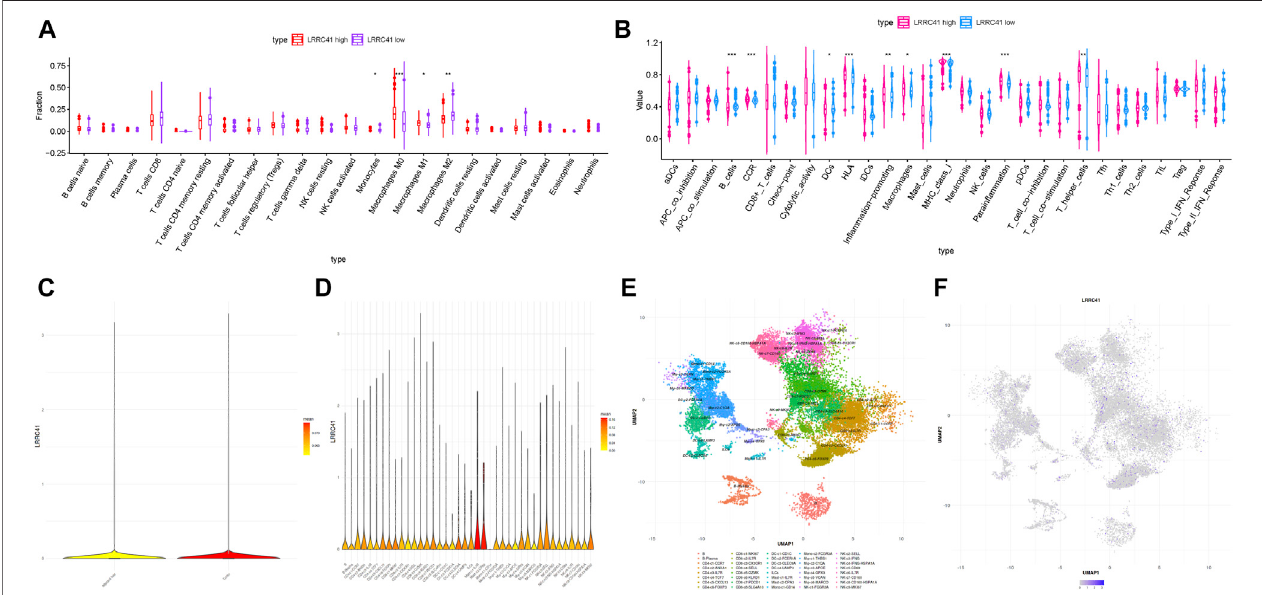
FIGURE9| DiscrepancyoflowandhighLRRC41expressionsubgroupsintermsofTIMEcharacterization. (A) ComparisonofCIBERSORTresultsintwoLRRC41 expression subgroups. (B) Difference of immune-related signatures between low- and high-LRRC41 subgroups. Single-cell RNA sequencing analysis of LRRC41 abundance in various tissues and immune cell subtypes of HCC patients. (C) Analysis of the enrichment of LRRC41 in tumor and adjacent liver. (D) Analysis of the enrichment of LRRC41 in immune cell subtypes in tumor tissue. (E) (Uniform Manifold Approximation and Projection) UMAP map of immune cells in tumor. (F) UMAP map of the LRRC41 expression level in tumor tissue.